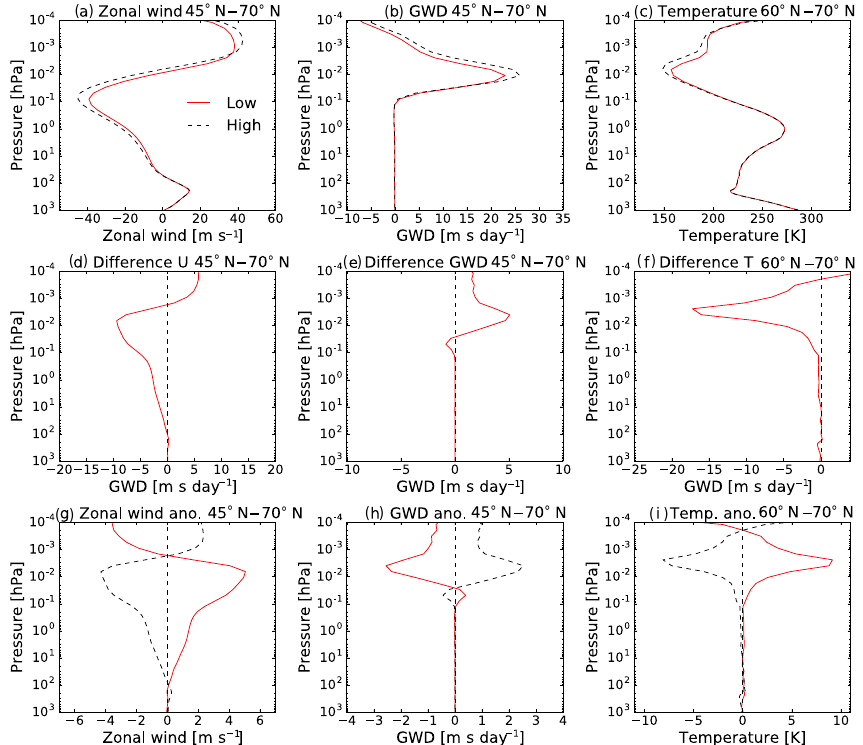
Figure 5. The July zonal wind (a, d, g) and the GW drag (b, e, h) between 45–70 ◦ N and the temperature (c, f, i) between 70–90 ◦ N for anomalously low and high temperatures in the winter stratosphere (1–10hPa, 60–40 ◦ S) (a–c) and the differences between them (d–f) and their anomalies (g–i) , for the case where there are no GWs in the winter hemisphere. The red continuous lines show the results for anomalously low temperatures and the black dashed lines show the results for the anomalously high temperatures.